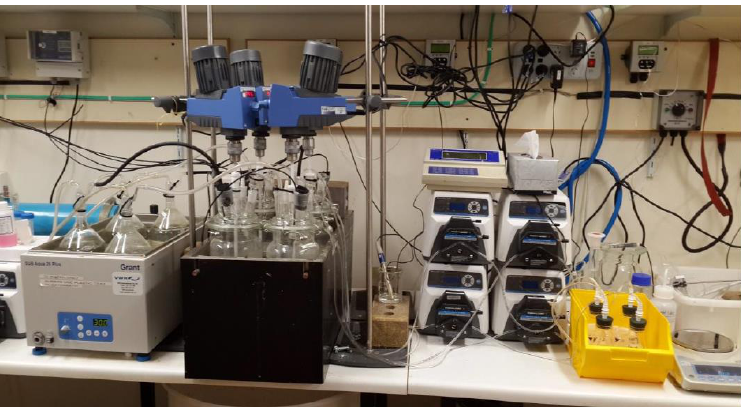
Figure 2. Bioreactor set up for pyrite oxidation experiments showing Dreschel bottles in water bath, stirred tank reactors in water bath, and pumps used for dosing NaOH